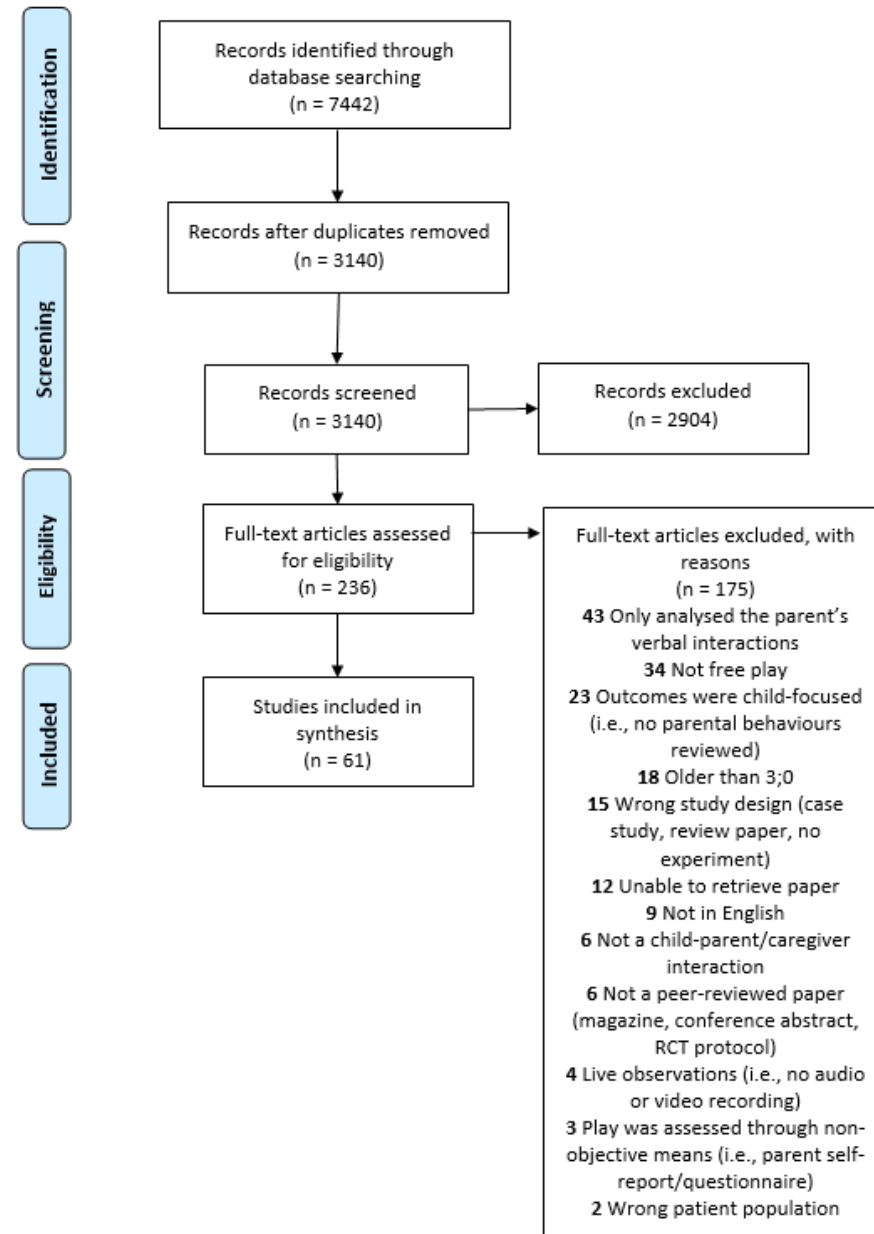
Figure 1. PRISMA systematic review flow diagram.